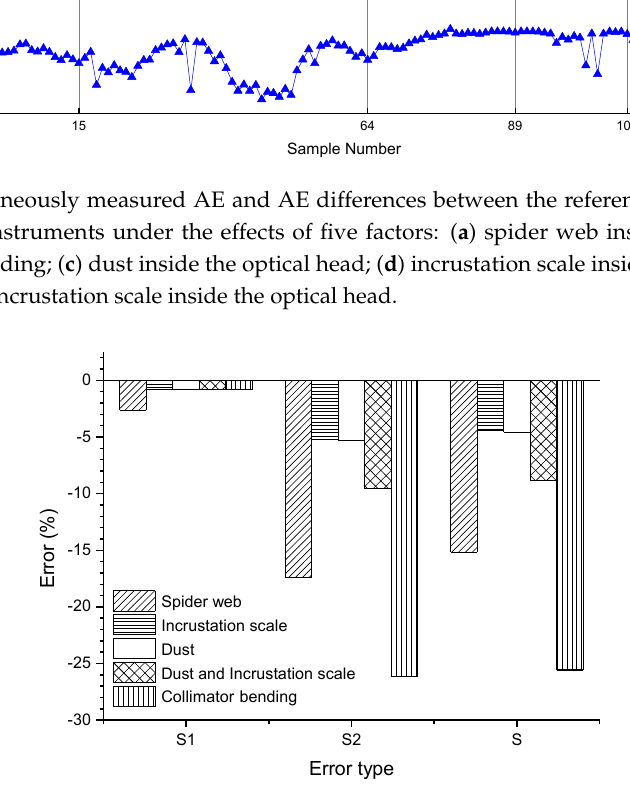
Figure 10. Error of the AE retrieved under the effect of different factors. Table 3. Error of the Ångström exponent (AE) retrieved between the experimental instruments and the reference instrument.